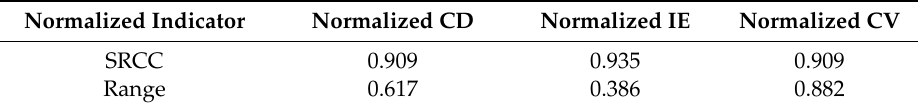
Table 4. The Spearman’s rank correlation coe ffi cients (SRCC) and range of each